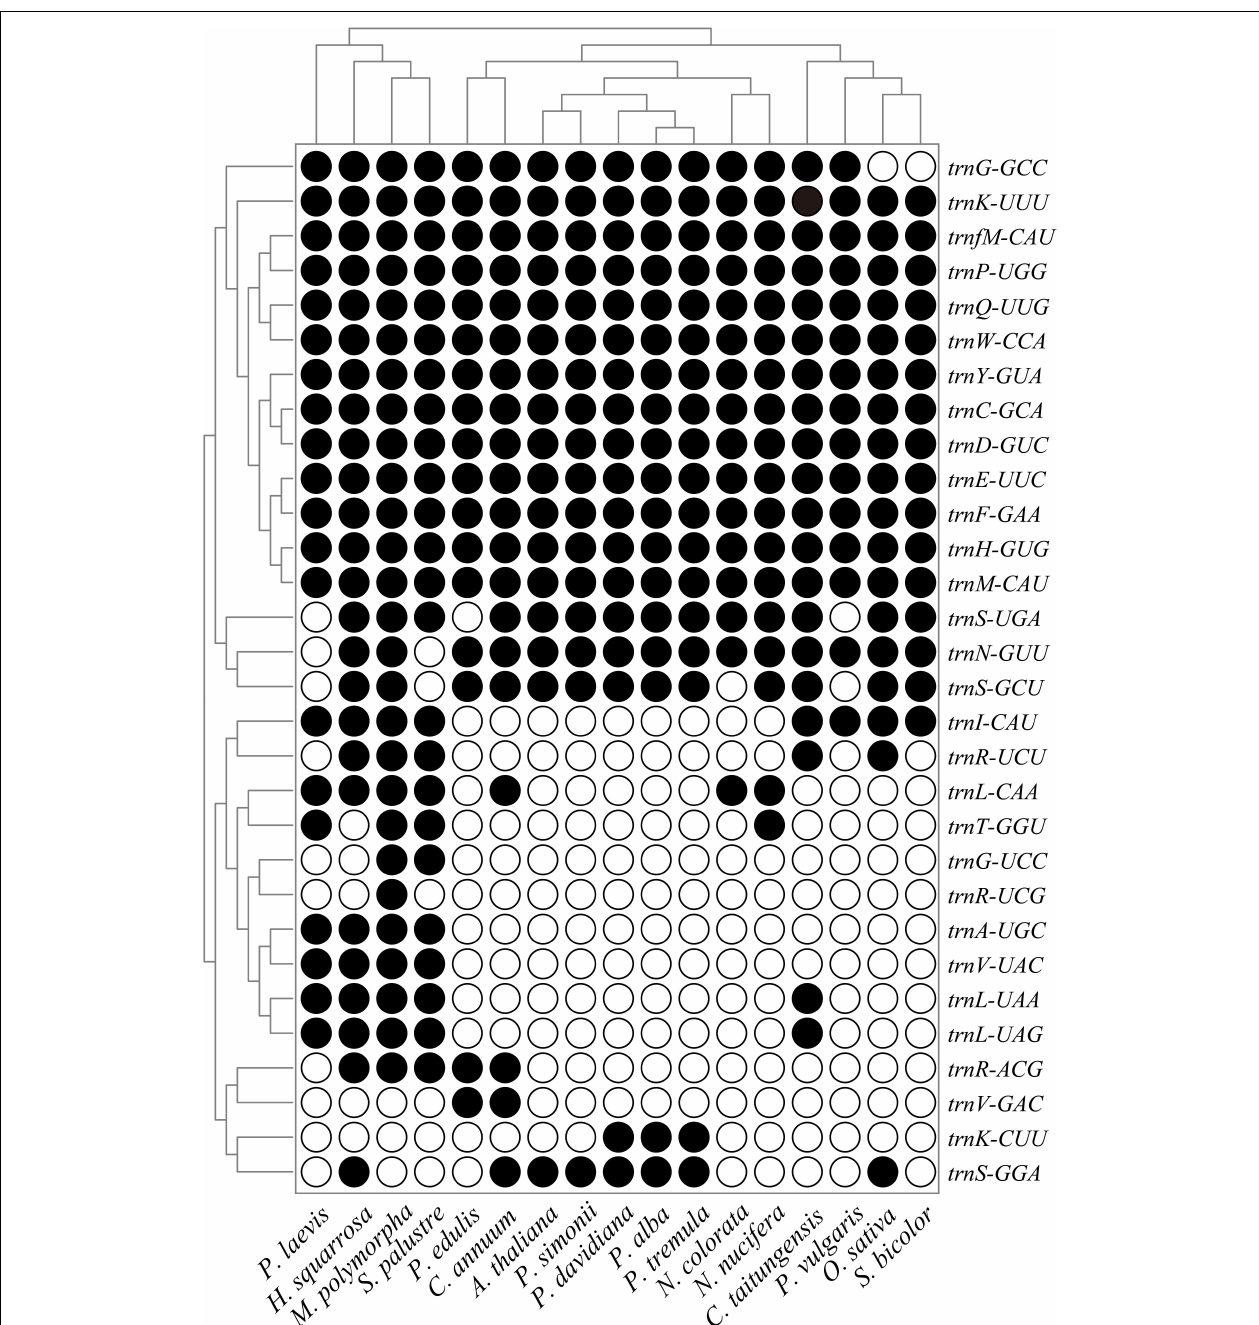
FIGURE 5 | Mitochondrial tRNA gene contents among 17 representative plants. Black circle, gene is present; White circle, gene is absent. Species names are abbreviated as shown in Supplementary Table S1